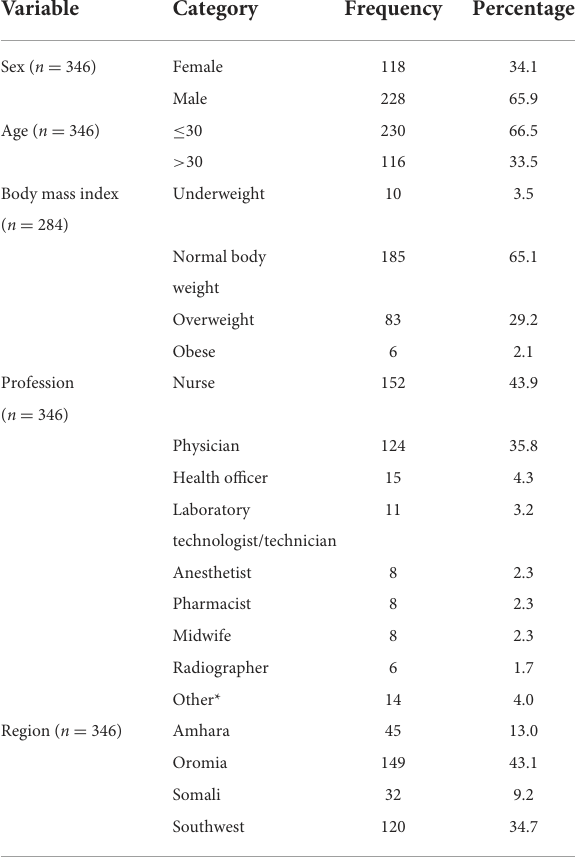
TABLE 1 Distribution of characteristics on demography, profession, and region of respondents of self-reported side effects of COVID-19 vaccines, Ethiopia, 2021.